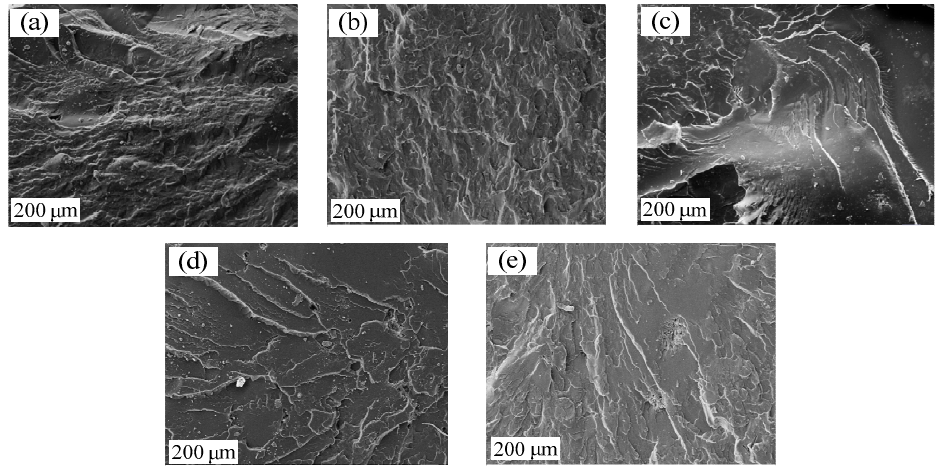
Figure 2. FT-IR spectra of ( a ) cross-linked polymer and the blend of PB and TTNO, ( b ) cross-linked polymers of different TTNO contents.